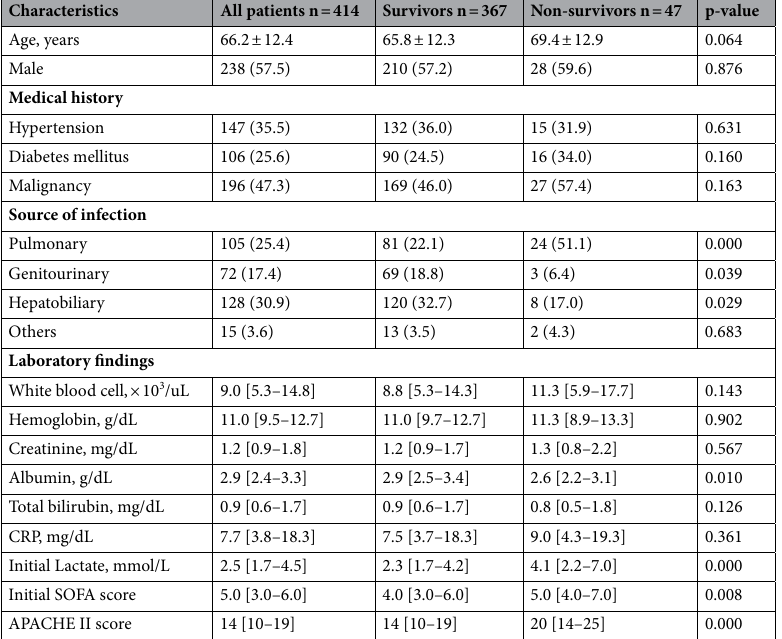
Table 1. Baseline characteristics of the study population. Values are expressed as the mean ± standard deviation, median [interquartile range], or number (%). CRP C-reactive protein; SOFA Sequential Organ Failure Assessment; APACHE Acute Physiology and Chronic Health